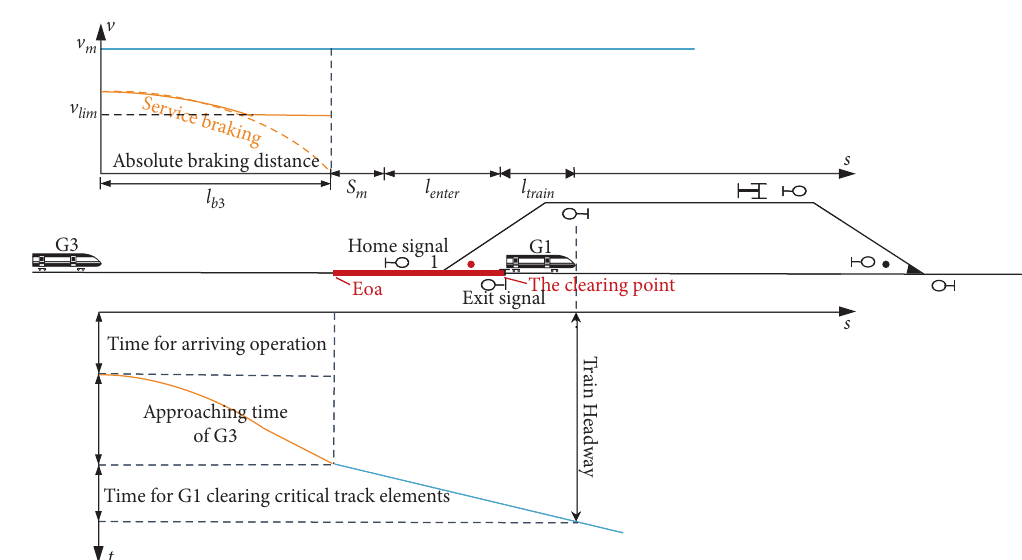
Figure 5: G1 and G3 both arrive at a station.